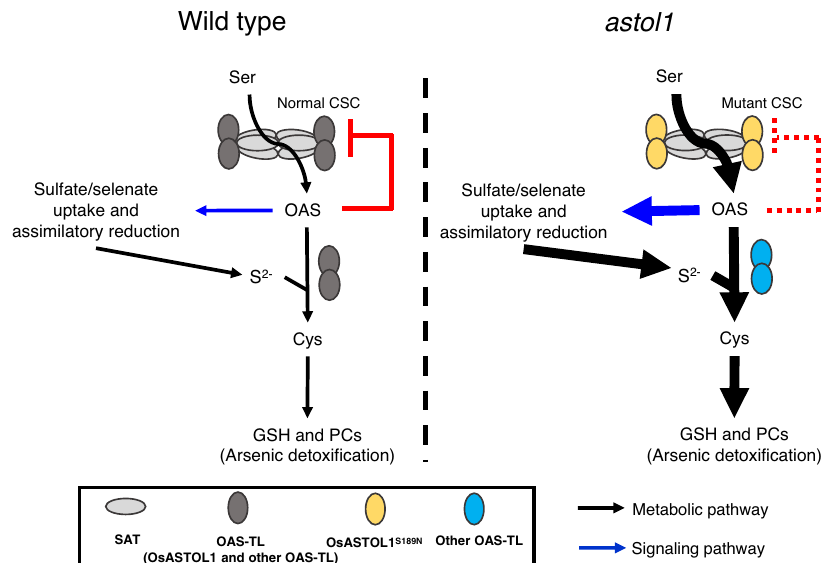
Fig. 6 Proposed working model for the regulation of OsASTOL1 in sulfur metabolism in rice. Schematic overview of enzymatic reactions (black arrows) and metabolites involved in the sulfur metabolism and its regulatory mechanism. In wild type rice, OAS is produced by cysteine synthase complex (CSC), which results in two effects: (i) induces expression of genes in sulfate uptake and assimilation (blue arrow) to enhance the supply of sul fi de; (ii) dissociates the cysteine synthase complex (solid red line) to inactivate SAT. These effects control the fl ux of S towards cysteine synthesis in vivo. However, in the astol1 mutant, the mutated OsASTOL1 S189N protein is dif fi cult to be dissociated from the CSC by OAS (dotted red line), which results in SAT being constitutively active and producing more OAS. Increased OAS level enhances sulfate/selenate uptake and assimilatory reduction and arsenic detoxi fi cation (bigger size of black and blue